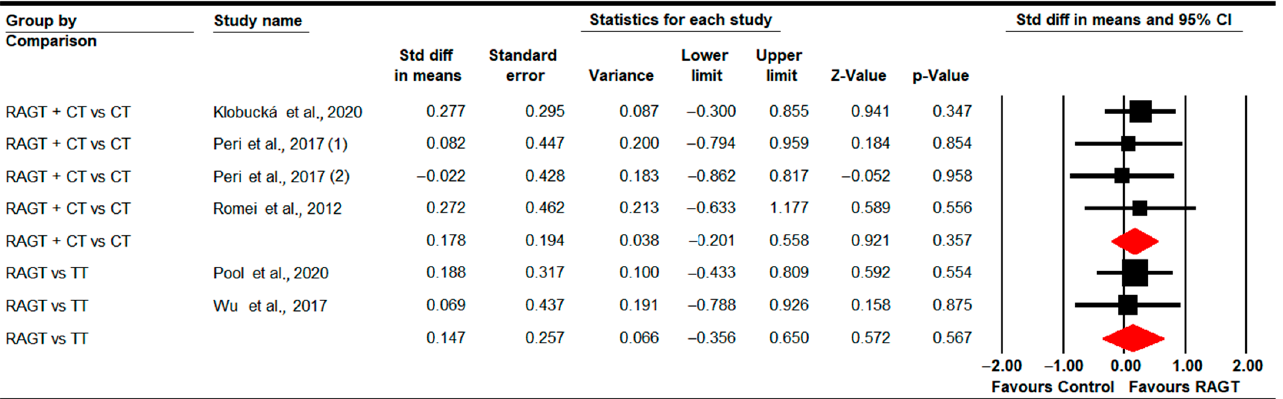
Figure 10. Forest Plot of Total Gross Motor Function (Post-Intervention Assessment) [83,87,89–91].